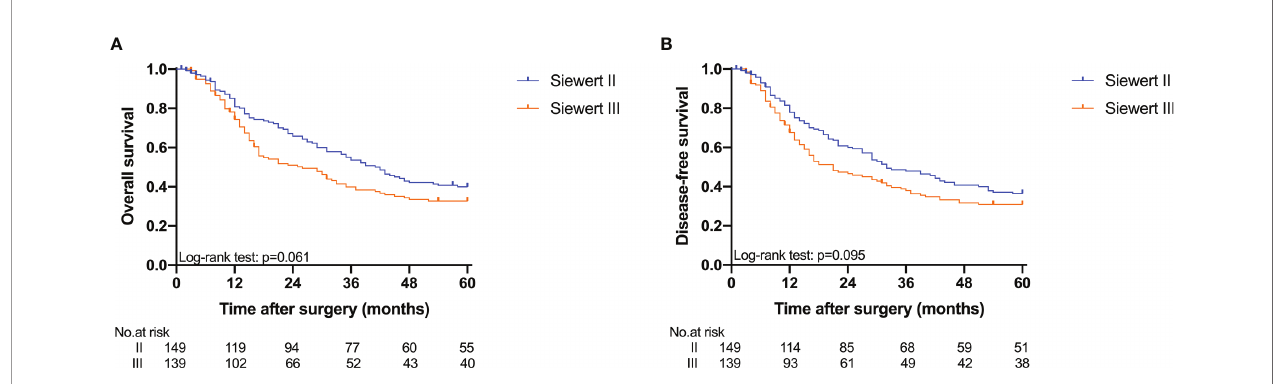
FIGURE 1 | Kaplan-Meier analysis for 5-year OS and DFS between Siewert type II and III AEG. (A) OS; (B) DFS.